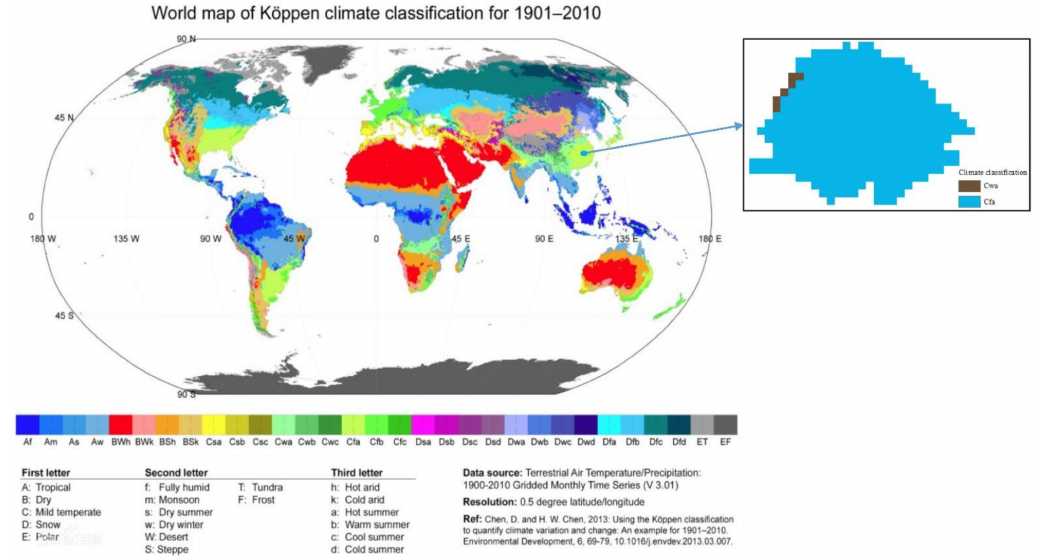
Figure A1. Map of Köppen-Geiger climate classification in JHP.